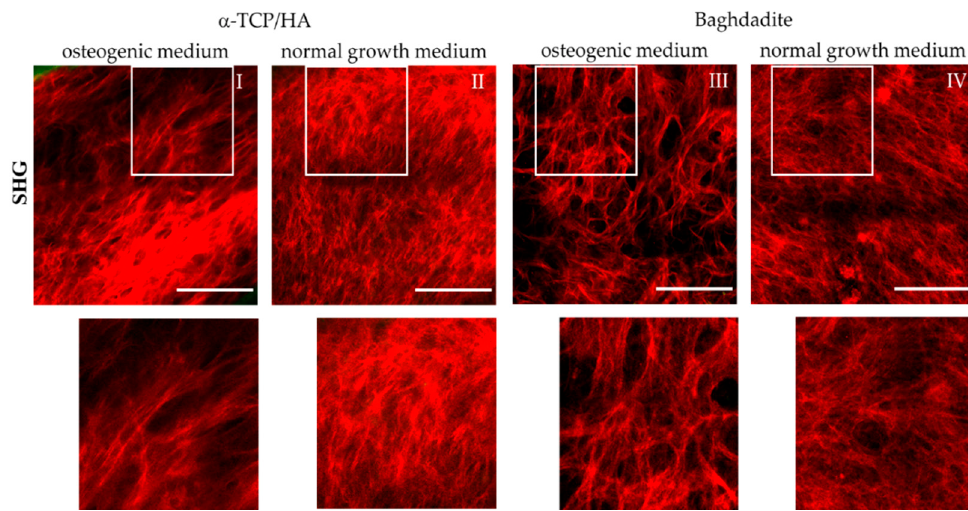
Figure 7. Multiphoton SHG recordings of collagen-I formed by MC3T3-E1 cells seeded in α -TCP/HA and baghdadite scaffolds. The scaffolds were initially cultivated in normal growth medium for four weeks before some scaffolds were transferred to osteogenic medium for additional three weeks ( I , III ) or kept for the same time in normal growth medium (references: ( II , IV )). The SHG signal (red) from collagen-I fiber networks is shown, which was present at great depths of several hundred µm. The areas outlined in white are shown enlarged in the bottom row. Images are representative of at least five regions from three different scaffolds. Scale bars: 100 µm.